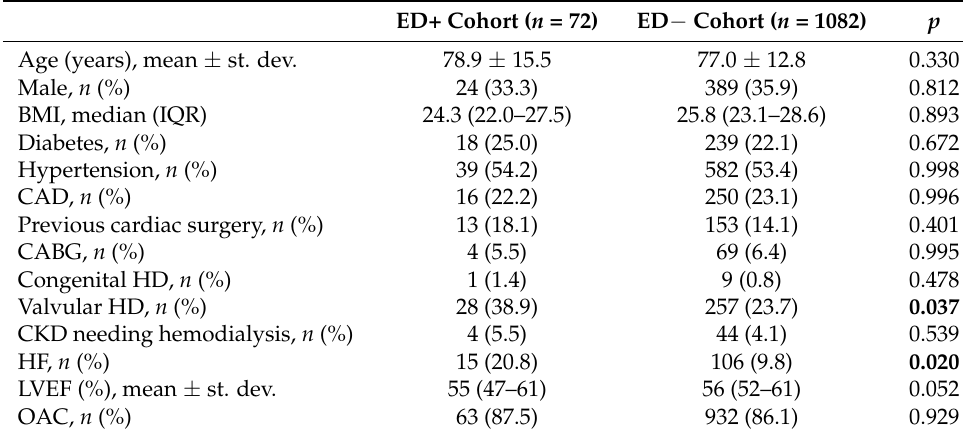
Table 1. Baseline characteristics of the study cohort.